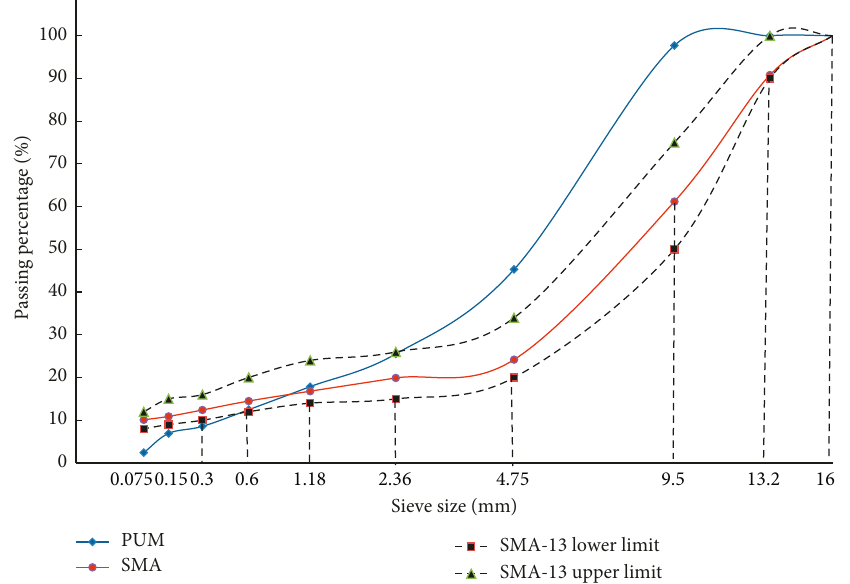
Figure 4: Gradations of SMA and